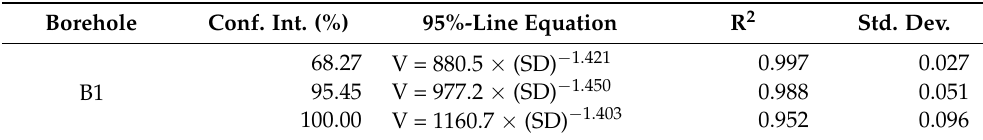
Table 3. Regression line with 95%-line equation, coefficient of determination (R 2 ) and standard deviation for borehole B1 for different confidence intervals. Borehole Conf. Int.